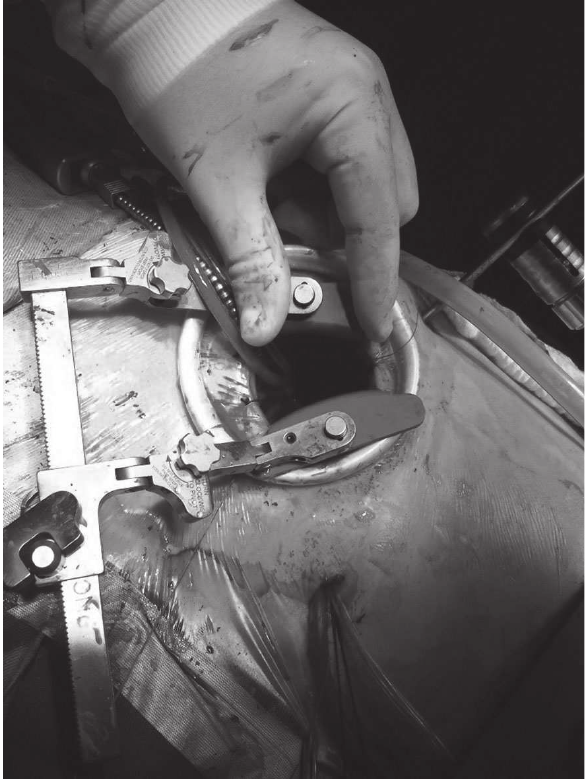
Fig. 1 – Acesso cirúrgico por minitoracotomia lateral